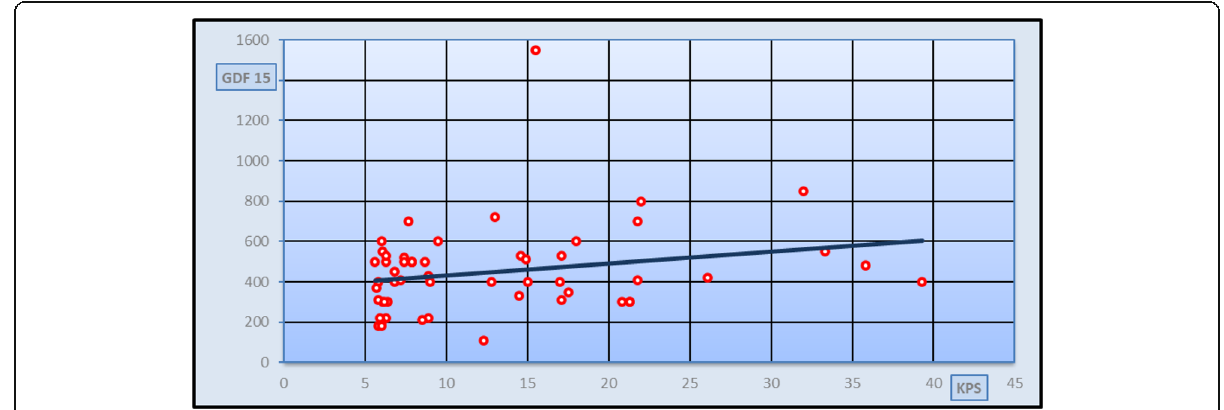
Fig. 1 Correlation study between GDF-15 and fibroscan in KPS in all patients group [ r = 0.086 and p = 0.034 (significant)]